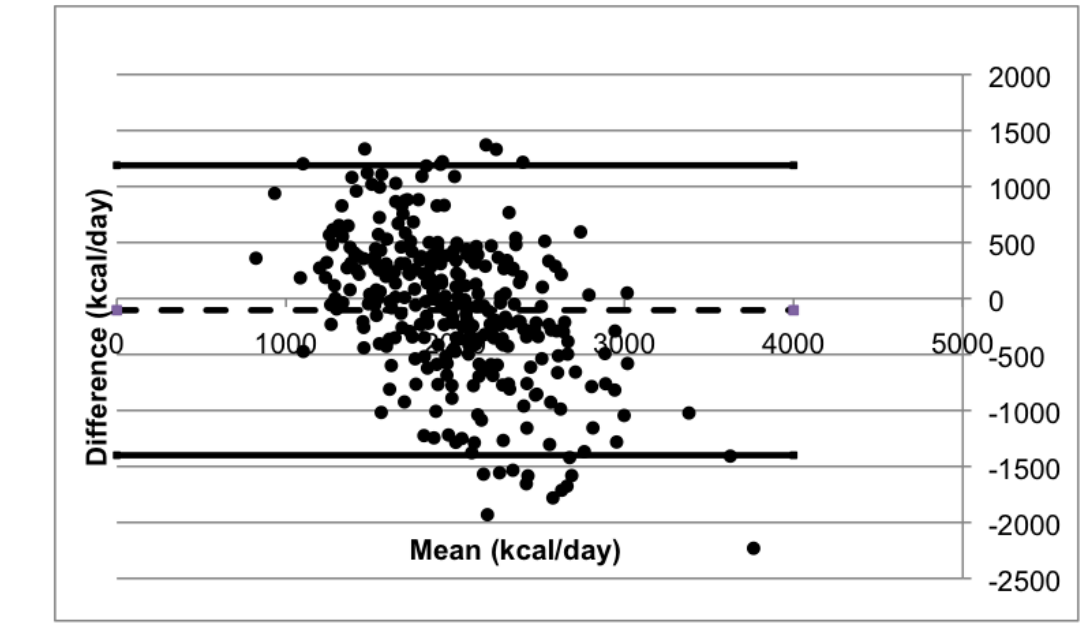
Figure 2. Bland-Altman (mean difference) plot of estimated nutrient intakes (kilo/day) by the test and reference method (N=304). Solid lines represent upper-lower limits of agreement, and the dashed line represents